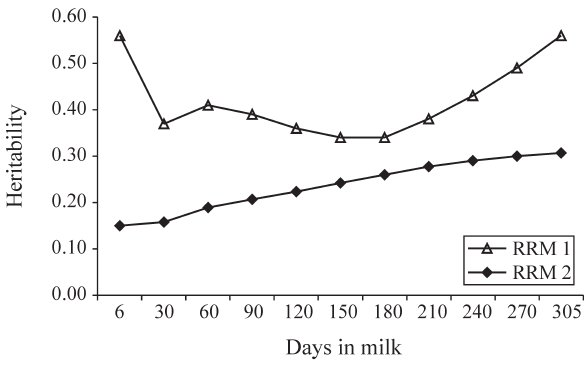
Figure 3 - Heritability estimates for milk yield during the different lacta- tion periods estimated by the RRM1 and RRM2 random regression mod-